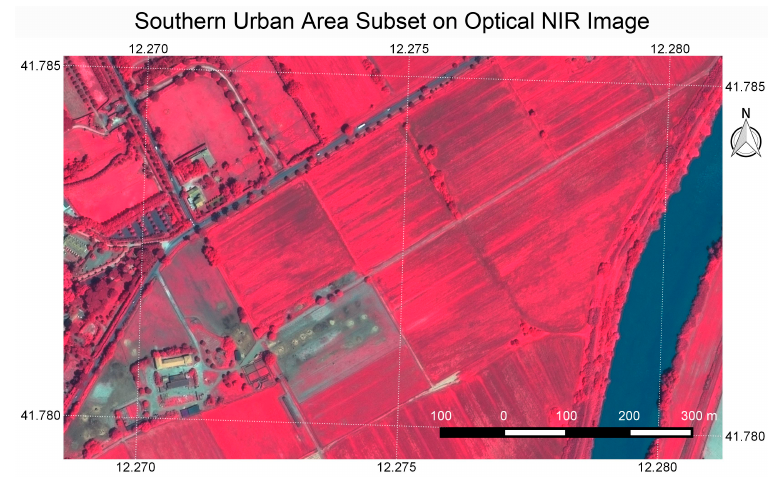
Figure 13. Southern urban area subset of Portus AOI (same extent as Figure 12) on Pleiades image acquired on 8 May 2014, pan-sharpened to 0.5 m spatial resolution. NIR, R and G displayed as R, G and B respectively. Pleiades data provided by the European Space Agency.